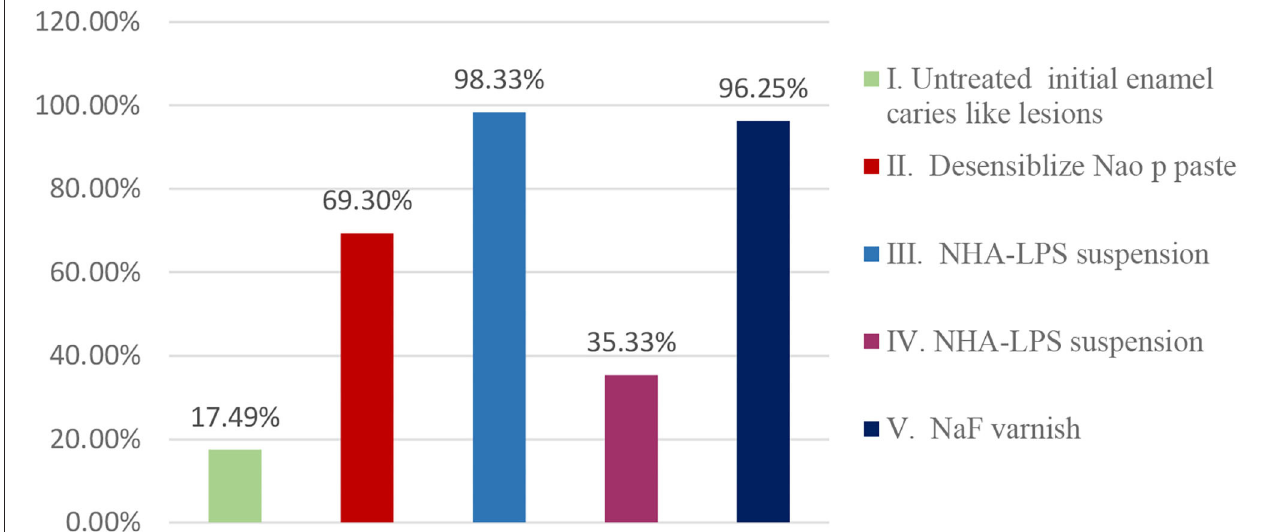
FIGURE 9 | Representation of the average percentage values of dead bacteria in all tested groups.